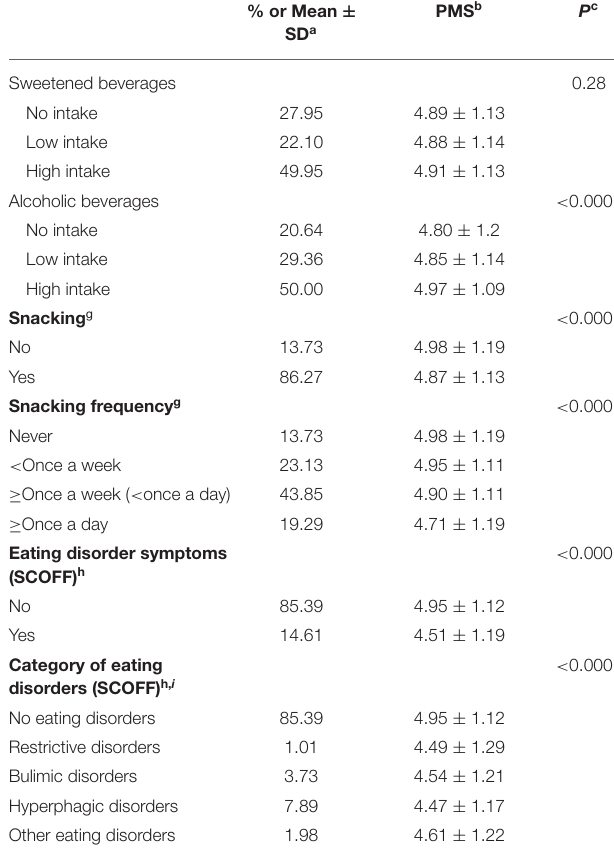
TABLE 2 | Descriptive characteristics of the outcome variables (NutriNet-Santé cohort study,